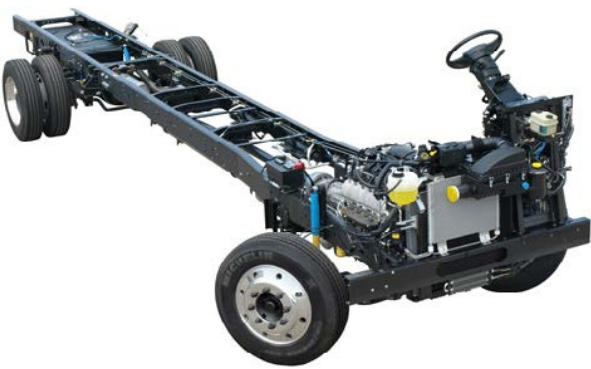
Figure 1. TATA-1612 truck ladder frame view [6] . Figure 1. A ladder chassis frame (truck) view